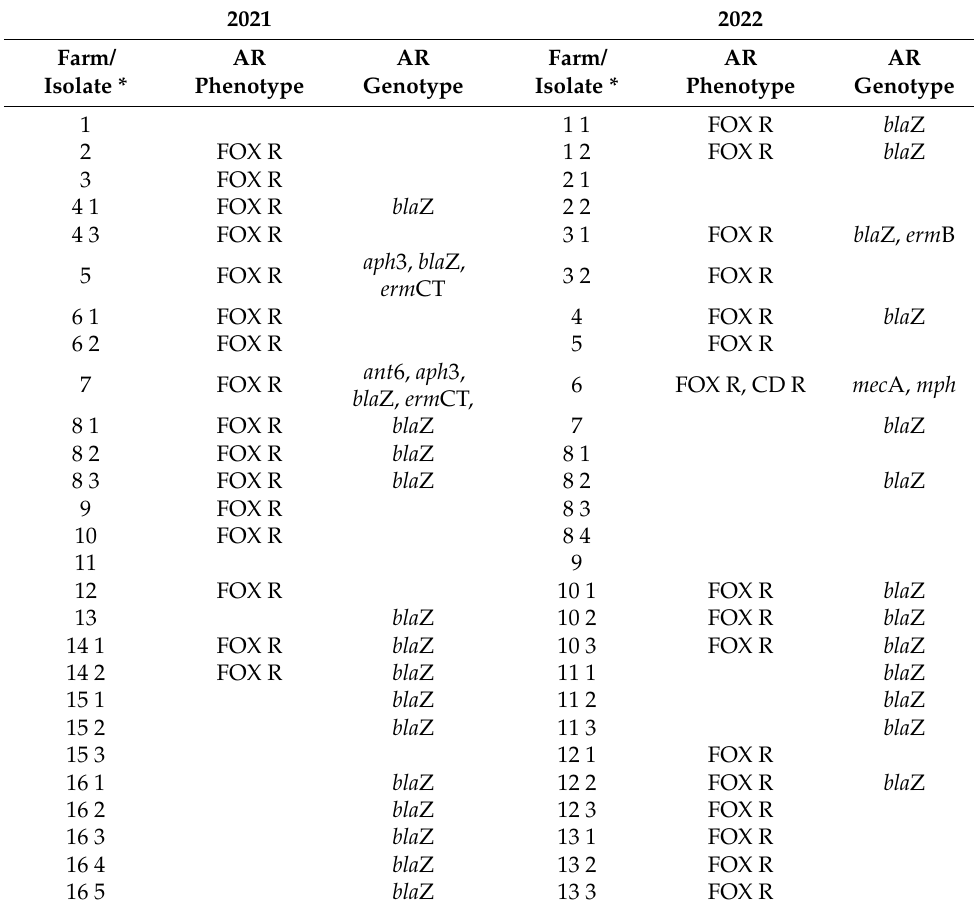
Table 2. List of isolates in the year 2021 or 2022 with respective AR phenotypes for the antibiotics for which resistance (R) was detected, i.e., cefoxitin (FOX) and clindamycin (CD), and the genotypic AR